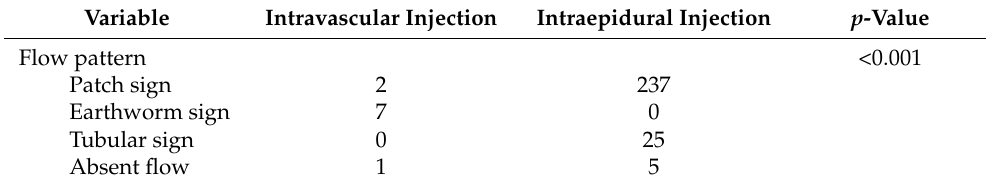
Table 2. Incidence of intravascular caudal epidural injection by flow pattern under Power Doppler ultrasonography.